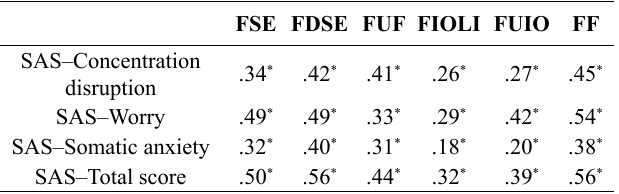
Table 3. Correlation Matrix between Performance Failure Appraisal Inventory (PFAI) and Sport Anxiety Scale–2